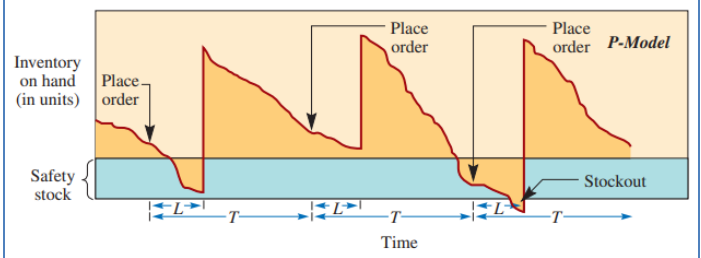
Figure 1: Fixed-Time Period Inventory Model: Source: Jacobs and Chase (2018), Operations and Supply Chain Management